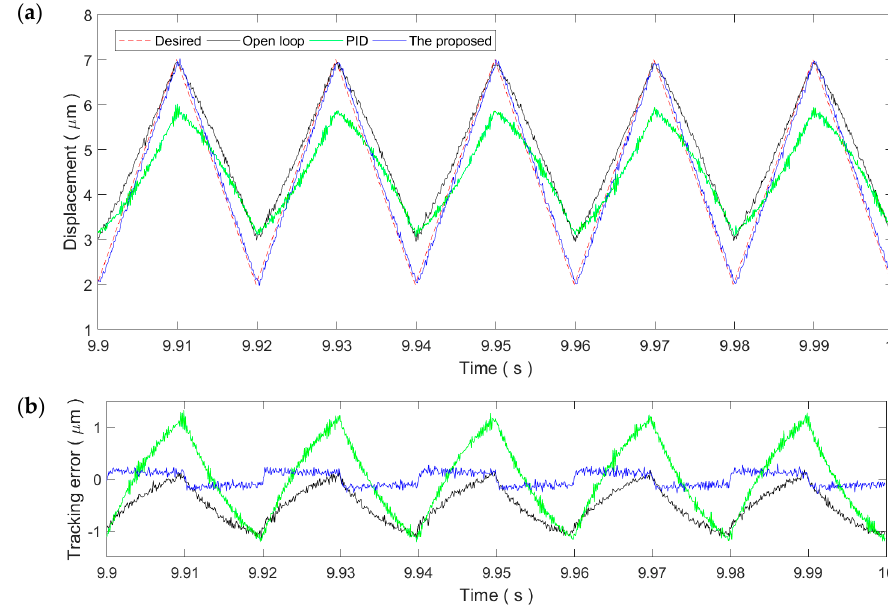
Figure 10. Tracking of the 50 Hz triangular trajectory: ( a ) Time plot and ( b ) tracking error.